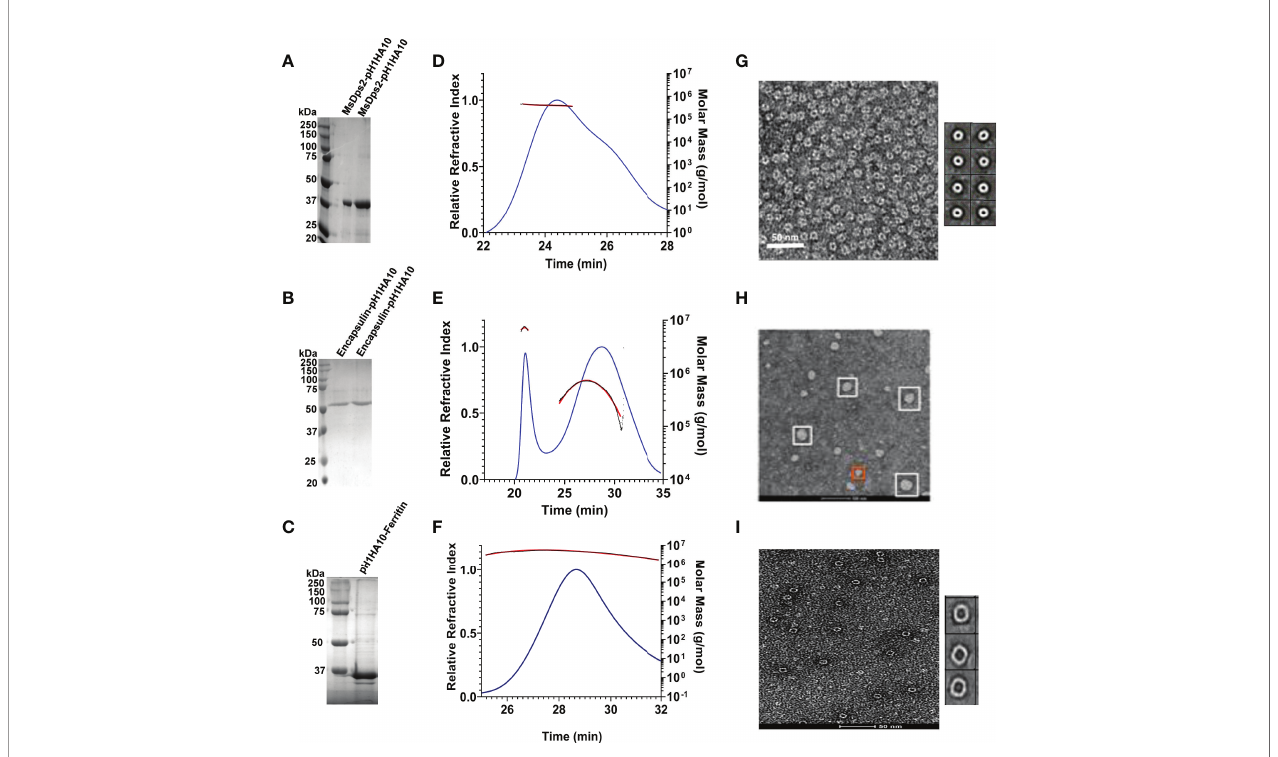
FIGURE 2 | Biophysical characterization of pH1HA10 fused nanoparticles. (A – C) SDS-PAGE analysis of puri fi ed stem-nanoparticles- (A) MsDps2-pH1HA10 (MW: 36.1 kDa), (B) Encapsulin-pH1HA10 (MW: 49.7 kDa) and (C) pH1HA10-Ferritin (MW: 38.6 kDa) under reducing conditions. (D – F) SEC-MALS pro fi le of (D) MsDps2- pH1HA10, (E) Encapsulin-pH1HA10, and (F) pH1HA10-Ferritin con fi rm the formation of oligomers of 12-mer, 180- mer and 24- mer, respectively. (G – I) Negative stain EM images of (G) MsDps2-pH1HA10 with left panel showing micrograph of negative stain EM images for MsDps2-pH1HA10, and the right panel showing 2D class averages obtained from the EM data. (H) Encapsulin-pH1HA10 forms heterogenous mixture of species in solution. (I) pH1HA10-Ferritin exists as homogenous oligomers as shown in negative stain image (left) and 2D class average